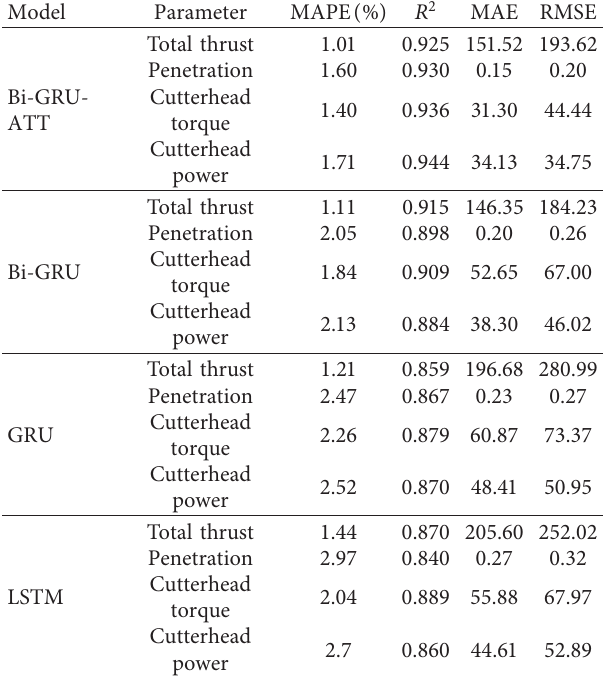
Table 2: Comparison of evaluation indexes of prediction results among different recurrent neural network